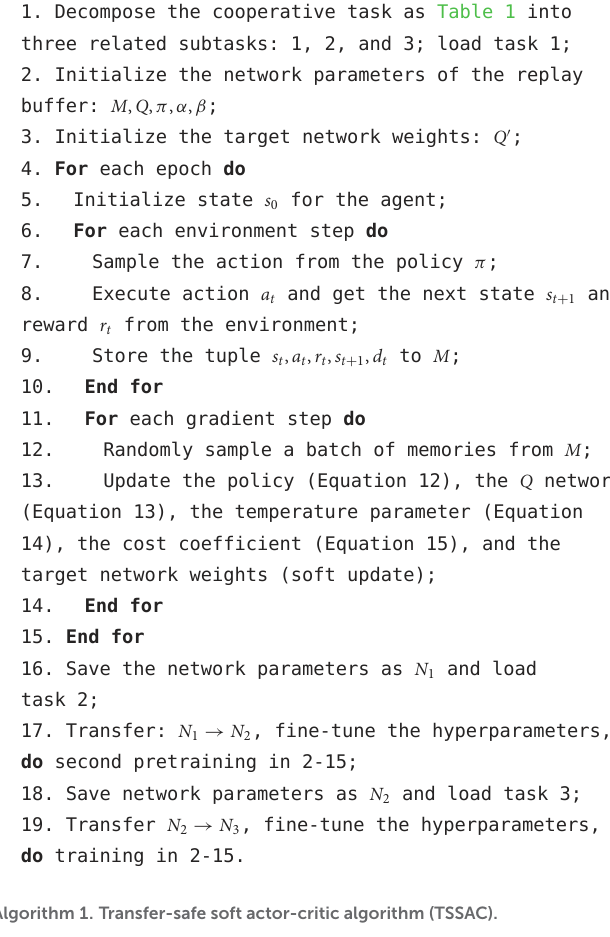
Algorithm 1. Transfer-safe soft actor-critic algorithm